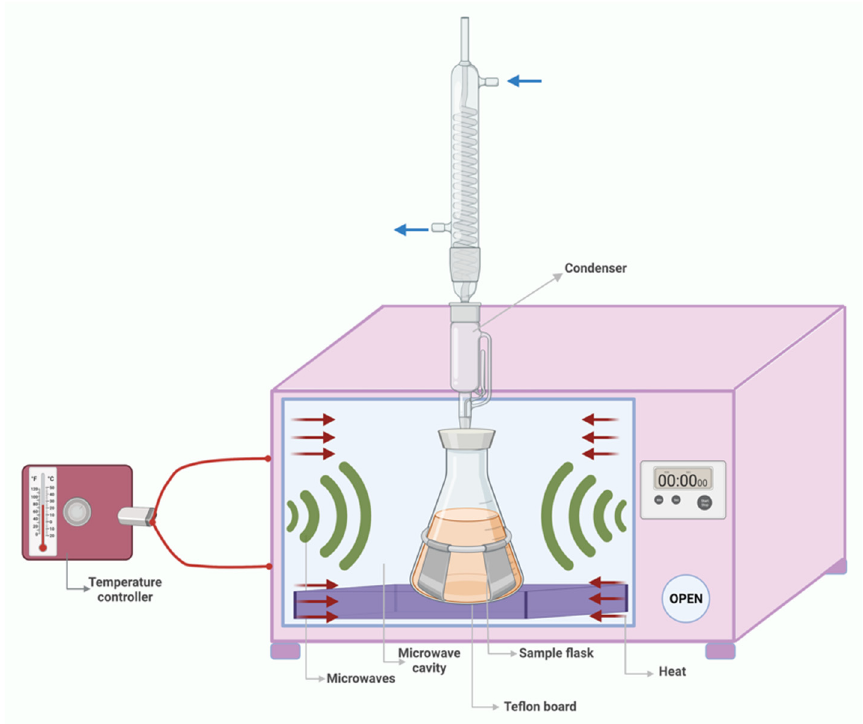
Figure 3. Microwave-assisted extraction.